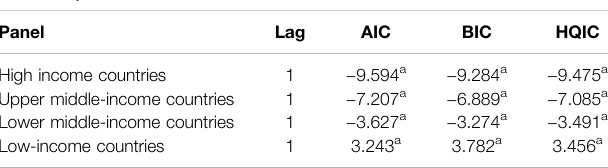
TABLE 7 | Selection order